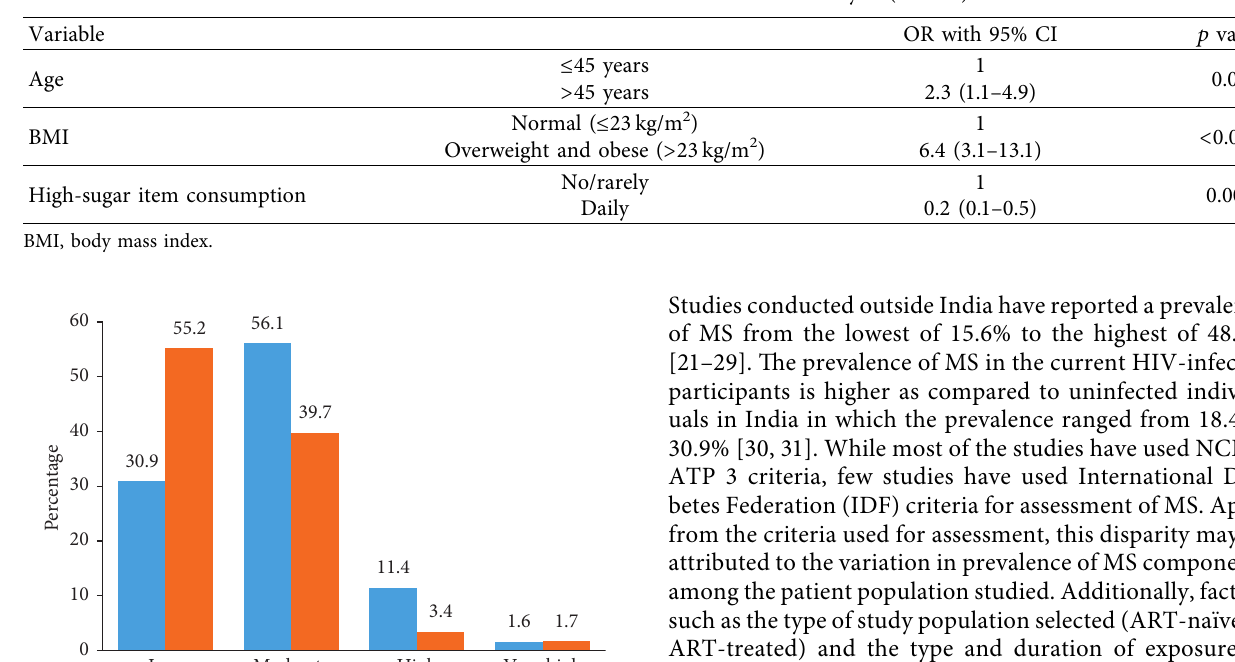
Table 4: Factors associated with MS on multivariate analysis ( n �